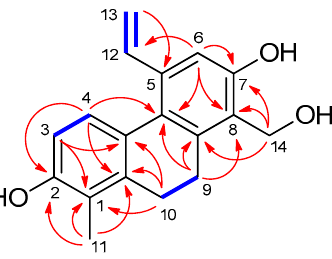
Figure 2. Key HMBC (H → C) and 1 H- 1 H COSY ( – ) interactions of maritin A ( 1 ). Compound 2 (maritin B) was obtained as a white amorphous solid. Its molecular formula was deduced to be C 18 H 18 O based on the protonated molecule in the HRESIMS at m/z [M + H] + 251.1429 (calcd. for C 18 H 19 O, 251.1430). The 1 H-NMR spectrum contained signals of two pairs of ortho -coupled aromatic protons ( δ H 7.47 d and 6.73 d, J = 8.2 Hz; 7.49 d and 7.11 d, J = 8.4 Hz), two methylenes ( δ H 2.88 m and 2.74 m, each 2H), a vinyl substituent ( δ H 6.77 dd, J = 17.9 and 11.4 Hz; δ H 5.59 dd, J = 11.4 and 2.0 Hz; δ H 5.22 dd, J = 17.9 and 2.0 Hz), and two methyl groups ( δ H 2.32 s and 2.24 s, each 3H) (Table 1). The HMBC correlations from H 3 -11 ( δ H 2.24) to C-1 ( δ C 120.9), C-1a ( δ C 137.7), and C-2 ( δ C 153.3), and further correlations between H-3 ( δ H 6.73), H-4 ( δ H 7.47), and C-2 showed that a methyl and a hydroxy group are situated on the adjacent carbons C-1 and C-2, respectively. The locations of another methyl ( δ H 2.32) and a vinyl substituent at C-7 and C-8, respectively, were apparent from the HMBC correlations H 3 -12/C-6, H 3 -12/C-7, H 3 -12/C-8, H-6/C-8, H 2 -9/C-8, and H-14/C-8. Further heteronuclear correlations were detected between H-3, H-5 ( δ H 7.49), H 2 -10 ( δ H 2.74), and C-4a ( δ C 128.4), H-4, H-6 ( δ H 7.11), H 2 -9 ( δ H 2.88), and C-5a ( δ C 133.3), and from H-5, H 2 -9, and H 2 -10 to C-8a ( δ C 134.1). The NOE cross-peaks H-6/H 3 -12, H 3 -12/H-13, H 2 -9/H-14b, and H 2 -10/H 3 -11